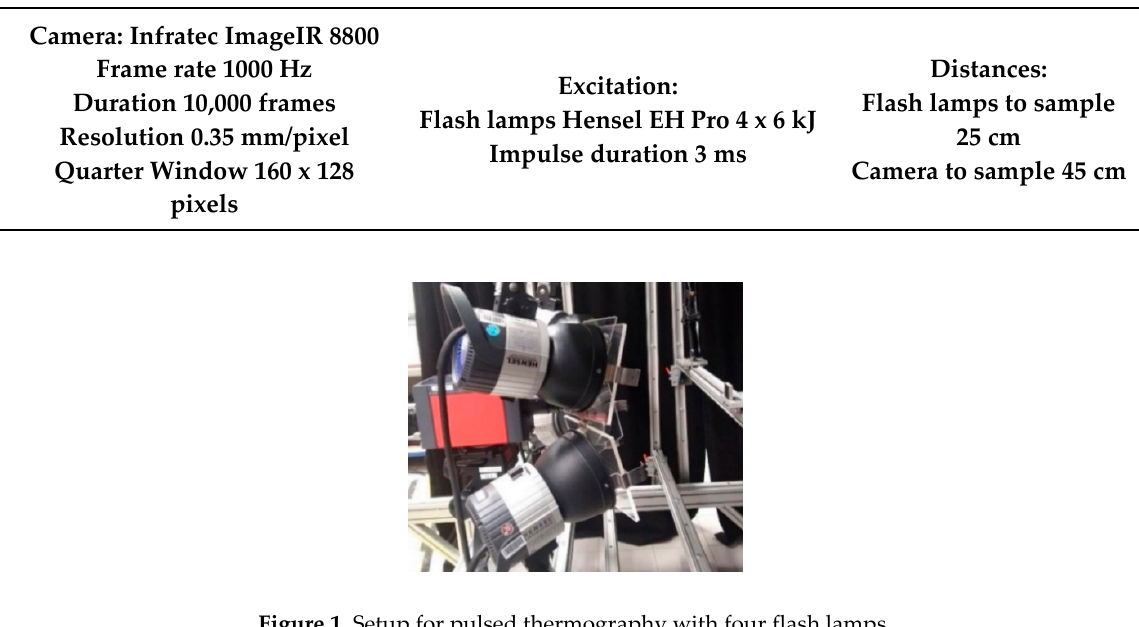
Table 1 . Thermographic parameters and set-up distances for pulsed thermography.